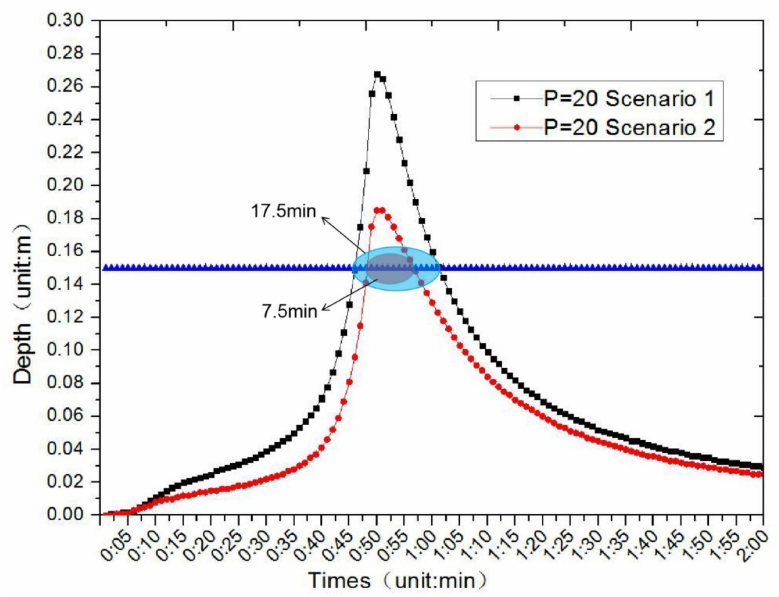
Figure 11. Comparison of the standing water depth for scenarios 1 and 2 for a storm with a recurrence interval (P) of 20